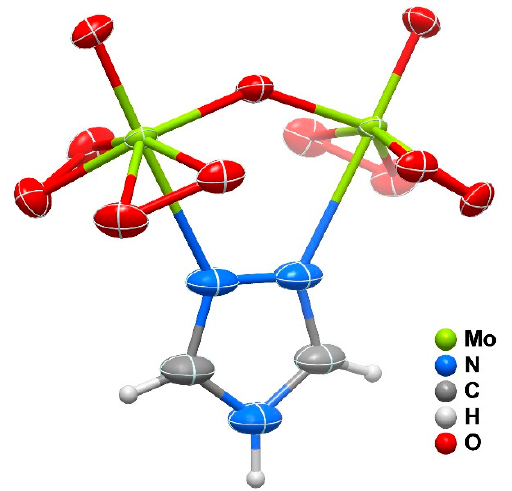
Figure 4. Schematic representation of the anionic dinuclear [Mo 2 O 2 ( µ 2 -O)(O 2 ) 4 (1,2,4-trz)] 2 − complex present in the crystal structure of 5 . Non-hydrogen atoms are depicted as thermal ellipsoids drawn at the 50% probability level and hydrogen atoms as small spheres with arbitrary radii. Table S1 in the Supporting Information gives selected bond lengths and angles for the crystallographically independent Mo center.